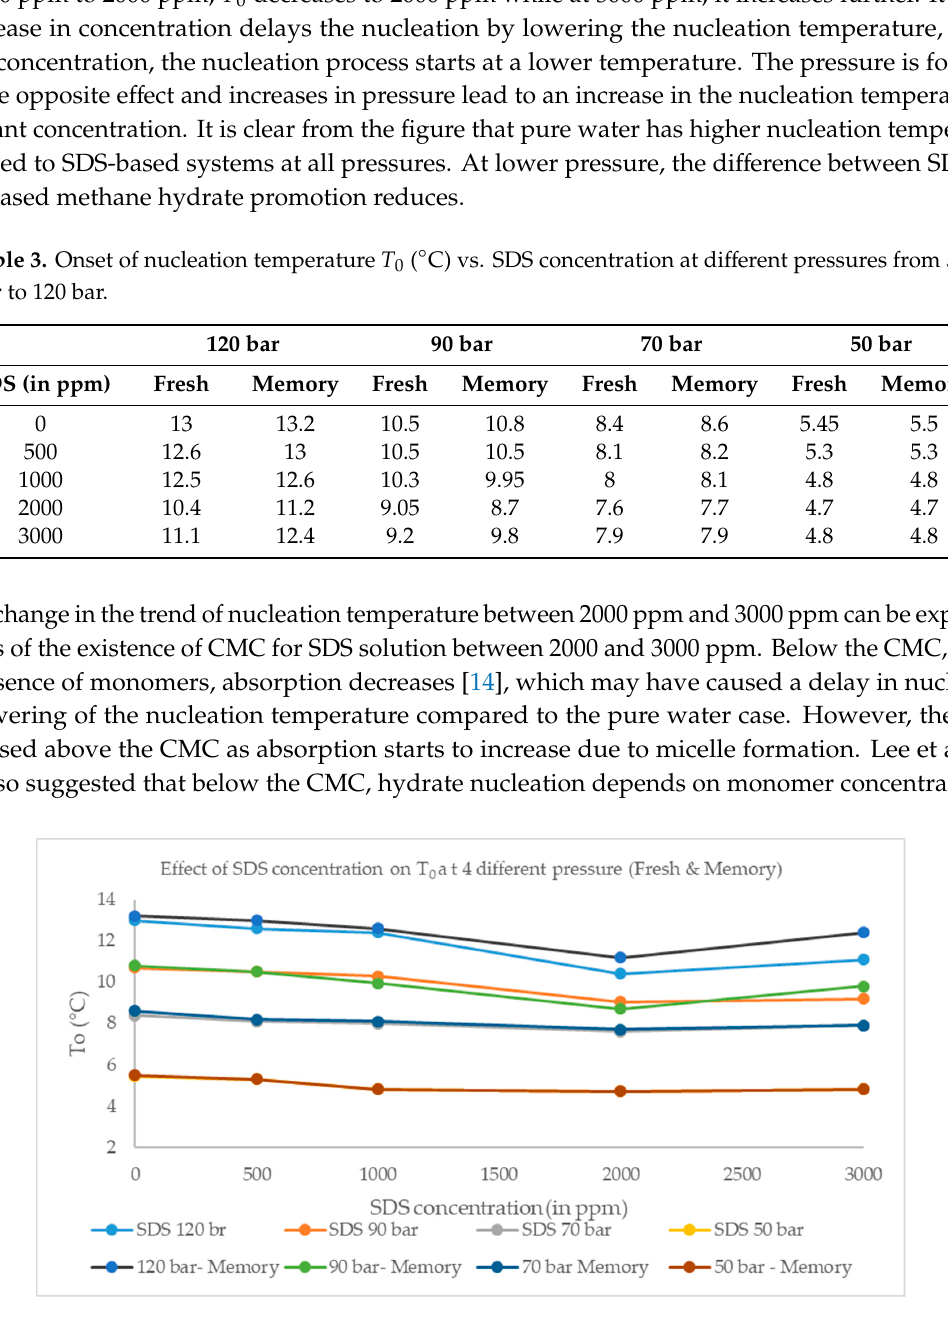
ff erent pressures both for fresh and memory o at di